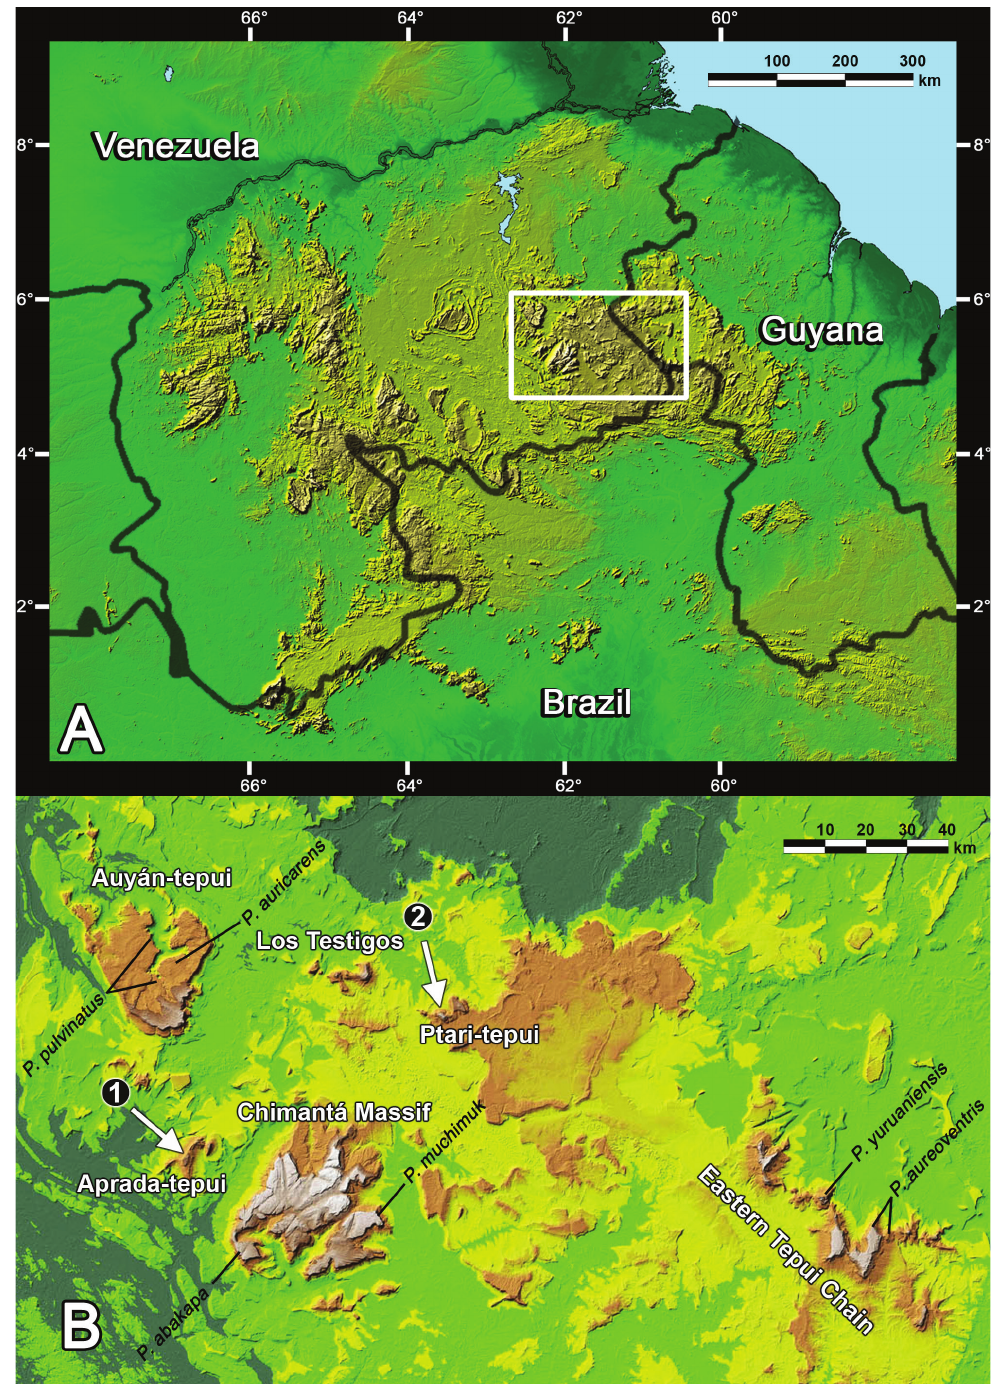
Fig. 1. A . Map of the Pantepui region, located in the western part of the Guiana Shield. The white rectangle corresponds to the area enlarged in (B). B . Distribution of known tepui summit Pristimantis species occurring east of the Rio Caroní in Venezuela and in western Guyana: P. aureoventris (Wei- Assipu-tepui and upper slopes of Mount Roraima), P. yuruaniensis (Yuruaní-tepui), P. muchimuk (Churí-tepui), P. abakapa (Abakapá-tepui), P. auricarens and P. pulvinatus (Auyán-tepui); (1) Aprada- tepui, type locality of Pristimantis jamescameroni sp. nov. (area enlarged in Fig. 6A); (2) Ptari-tepui, type locality of Pristimantis imthurni sp. nov. (area enlarged in Fig.